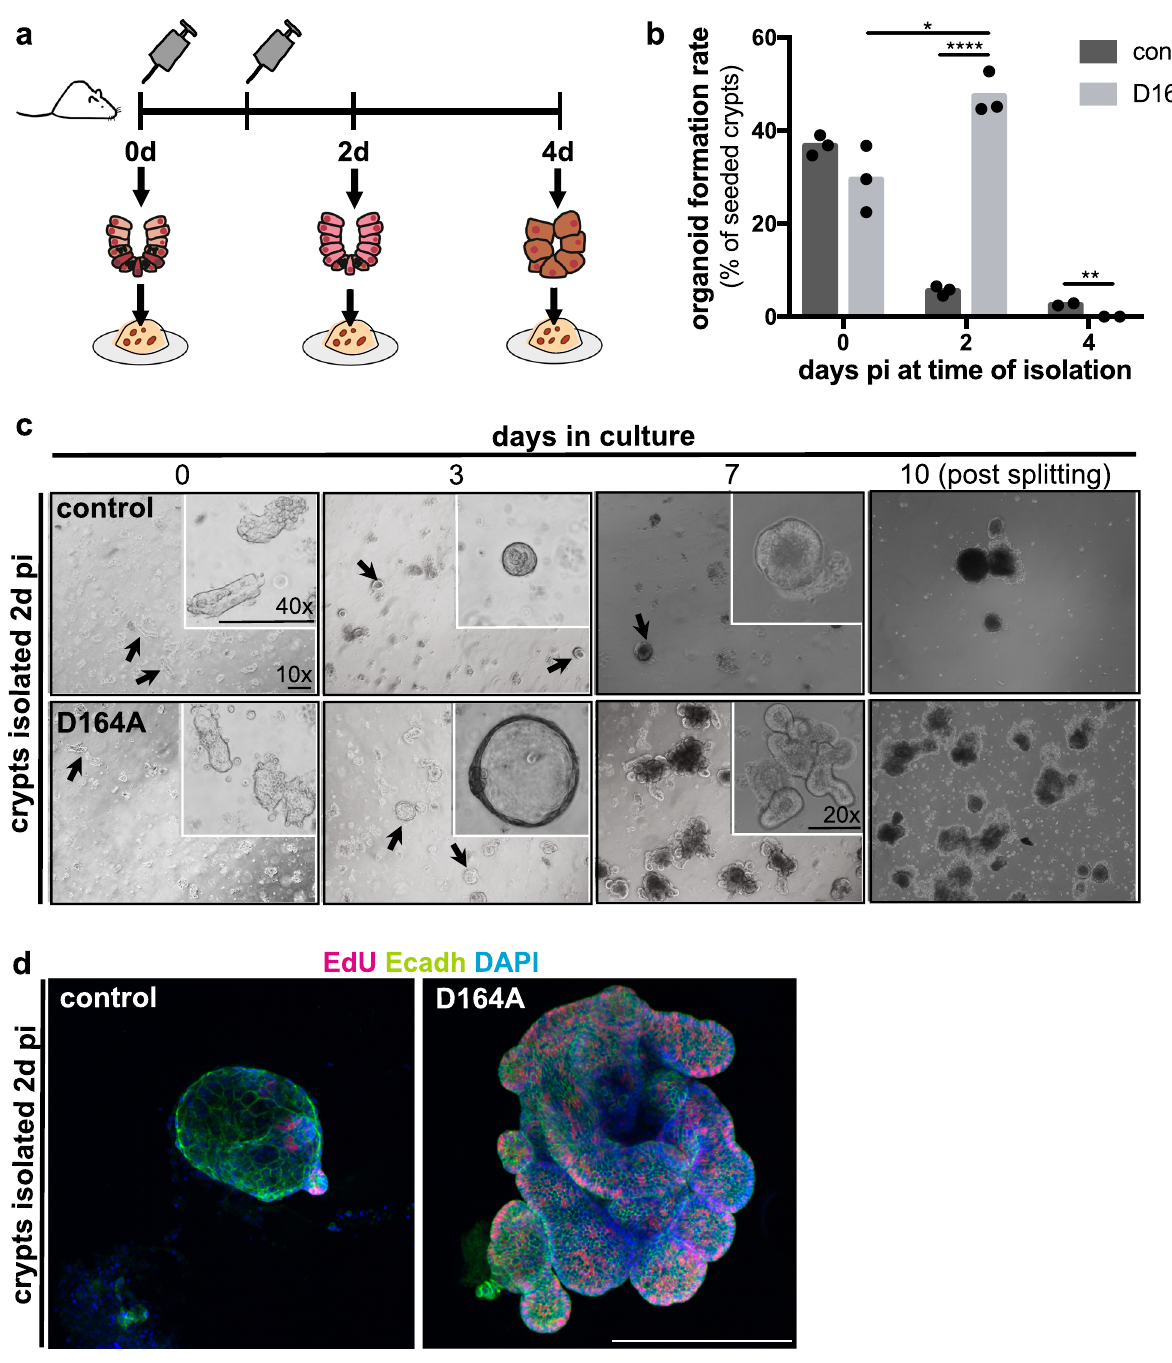
Fig. 3 Hyperproliferative IESCs expressing only Ctnnb1 D164A have an increased ability to form organoids. a Experimental design of organoid formation assay. b Organoid formation rate (in %) of control ( villin-CreER T2 ;Ctnnb1 wt/ fl ox ) and mutant ( villin-CreER T2 ;Ctnnb1 D164A/ fl ox ) crypts isolated 0, 2 and 4d pi. **** p < 0.0001, ** p = 0.0088, * p = 0.0207, as calculated by unpaired, two-tailed Student ’ s T-test ( n = 3). Barplot indicates mean rate. c Bright fi eld images of control and mutant organoids formed from crypts isolated 2d pi grown in Matrigel for 10 days. Insets show higher magni fi cation. Representative images of three biological replicates. Scale bars, 20 μ M. d Confocal images of crypts isolated 2d pi and grown in Matrigel for 7 days. EdU staining shows proliferating cells. E-cadherin (cell shape) and DAPI (nuclei) as counterstain. Scale bar, 20 μ M. Representative images of three biological